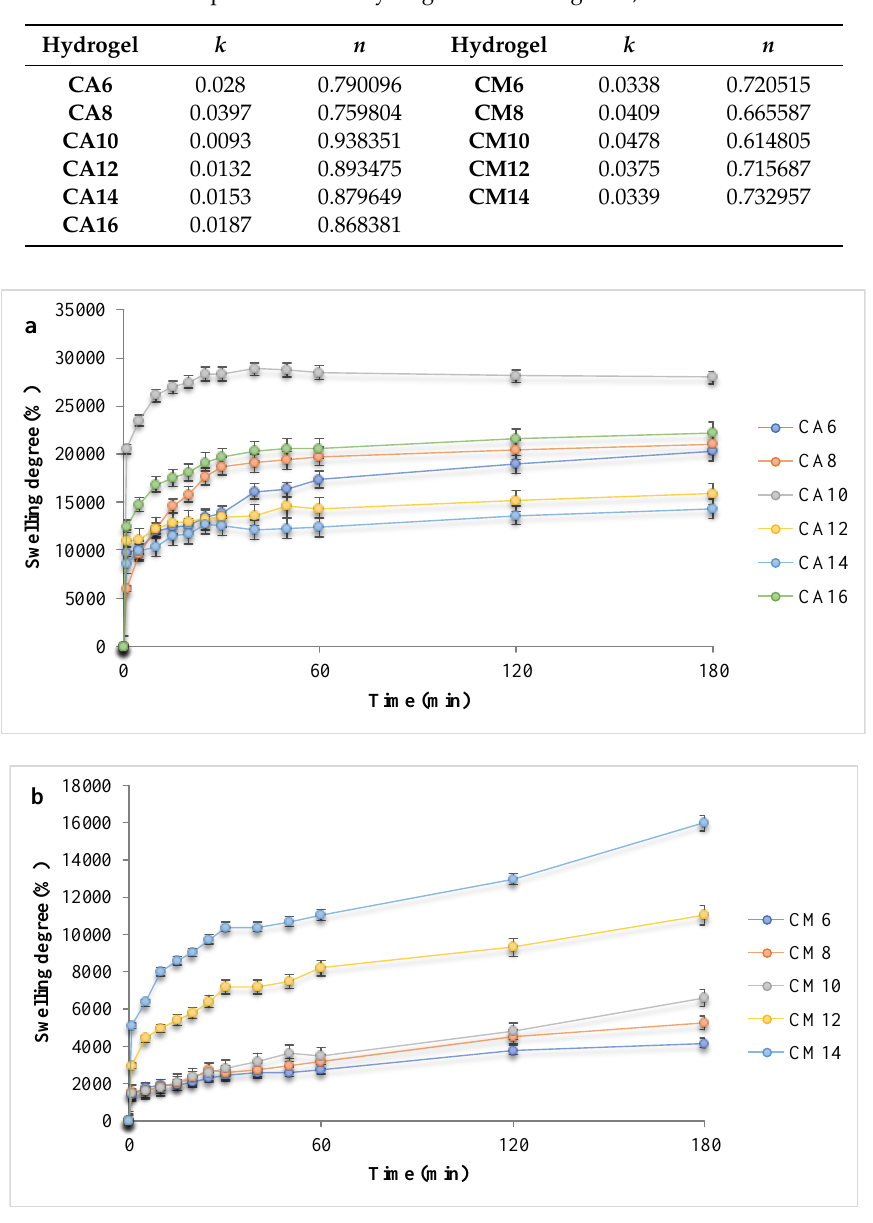
Table 2. Pore size variations with hydrogel